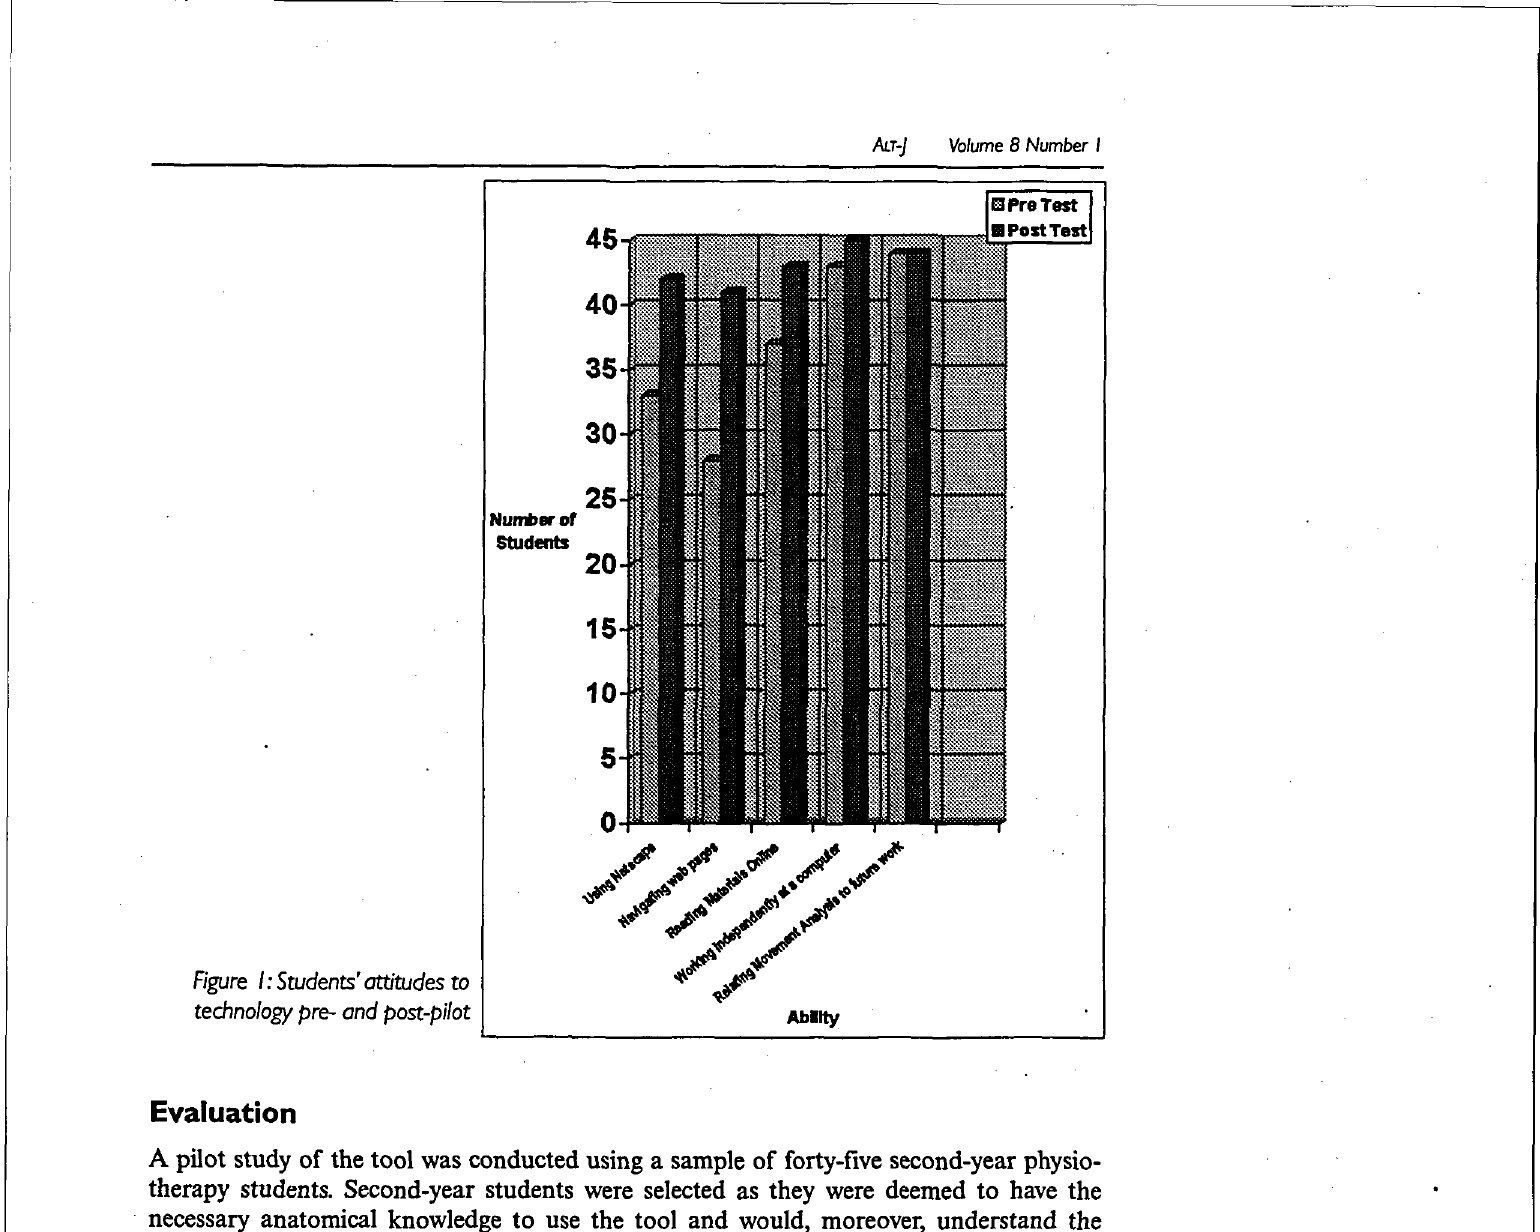
Figure I: Students' attitudes to technology pre- and